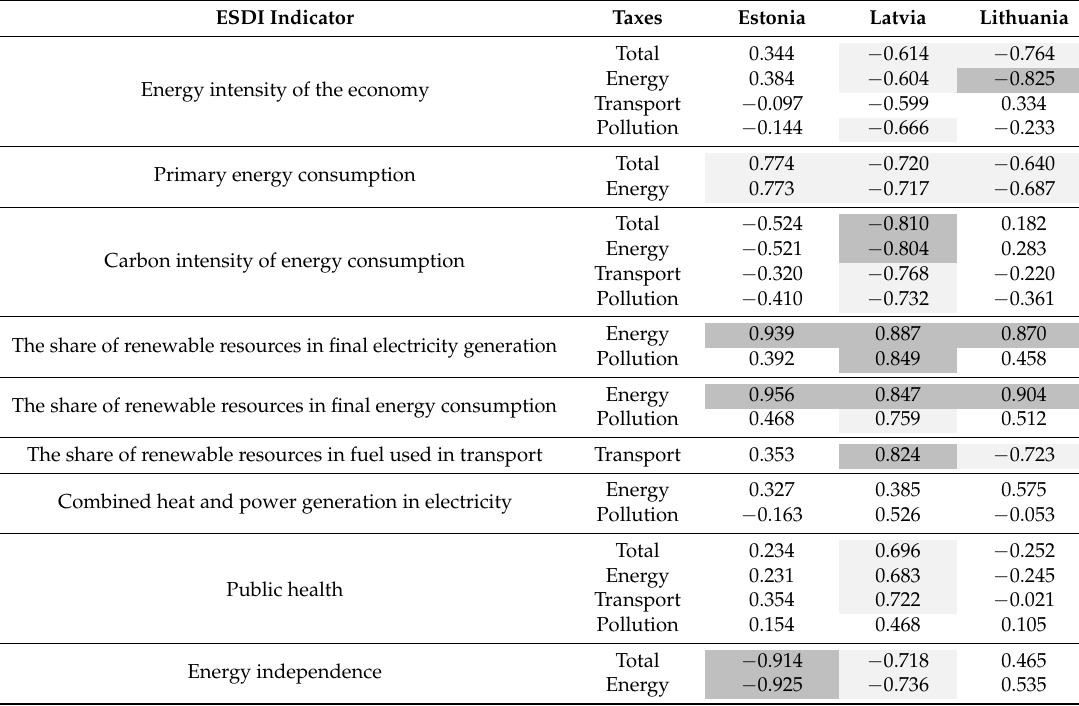
Table 10. Correlation between ESDI indicators and environmental